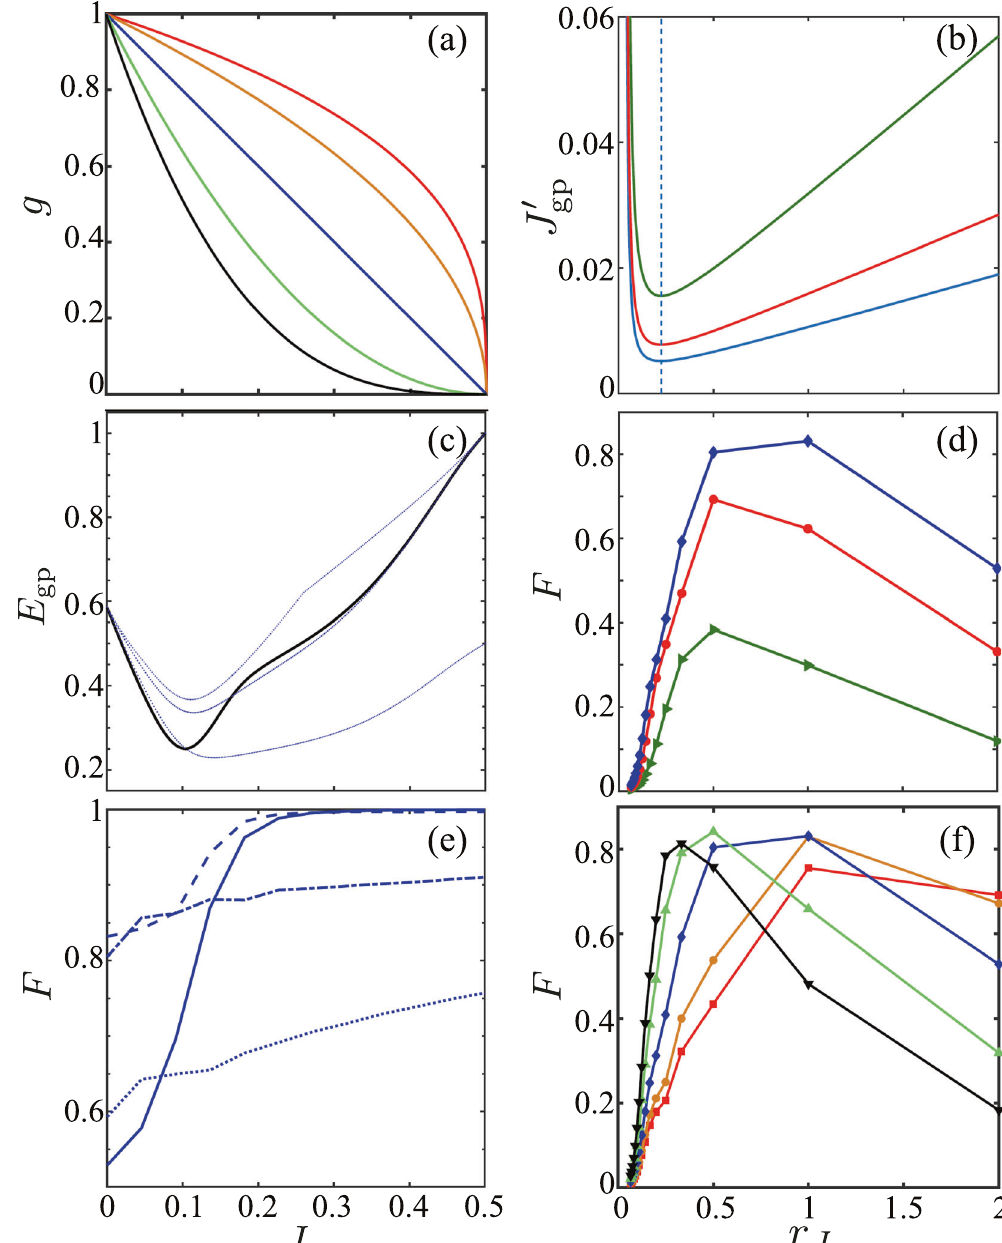
Fig. 5 Ramping from SF to MI phase. a Ramping trajectory in the parameter space of J and g for r g / r J = 1/3, 1/2, 1, 2, 3 from top to bottom. b Time derivative J 0 vs ramping index r J at r g / r J = 1, J ( T ) = 0, and T = 5 π / g , 10 π / g , and 15 π / g from top to bottom. c Energy spectrum of the gp lowest excited states vs hopping rate J for r g / r J = 1. Solid (dotted) curve is for the symmetric (asymmetric) state with the ground-state energy set to zero. d Fidelity F vs r J at r g / r J = 1, J ( T ) = 0, and T = 5 π / g , 10 π / g , 15 π / g from bottom to top. e Fidelity F vs J ( T ) = J for r J = 2 (solid), 1 (dashed), 1/2 (dot-dashed), and 1/3 (dotted) at r g / r J = 1 and T = 15 π / g . f Fidelity F vs r J at r g / r J = 1/3 (square), 1/2 (circle), 1 (diamond), 2 (triangle), and 3 (inverted triangle), J ( T ) = 0, and T = 15 π / g . In all plots, g (0) = 0, g ( T ) = 1, J (0) = 0.5, and Δ ( t ) ≡